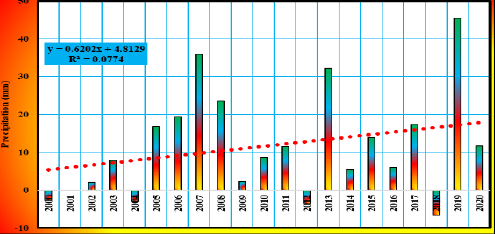
Figure 10: Represents Annual Average Temperature Deviation in Ghotki Figure 8: Non-Monsoon Season Rainfall Deviation in Ghotki district 2000-2020